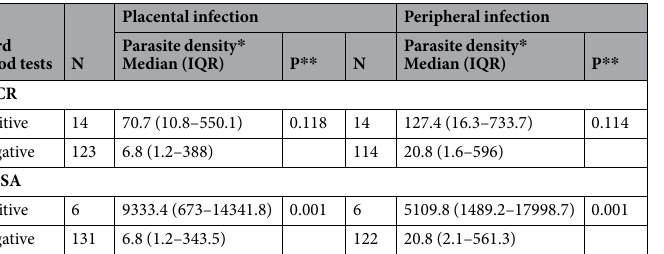
Table 5. Parasite density in maternal peripheral and placental blood among congenital malaria cases detected. * Parasite density (number of parasite/ μ L) determined by qPCR. ** P value determined by the